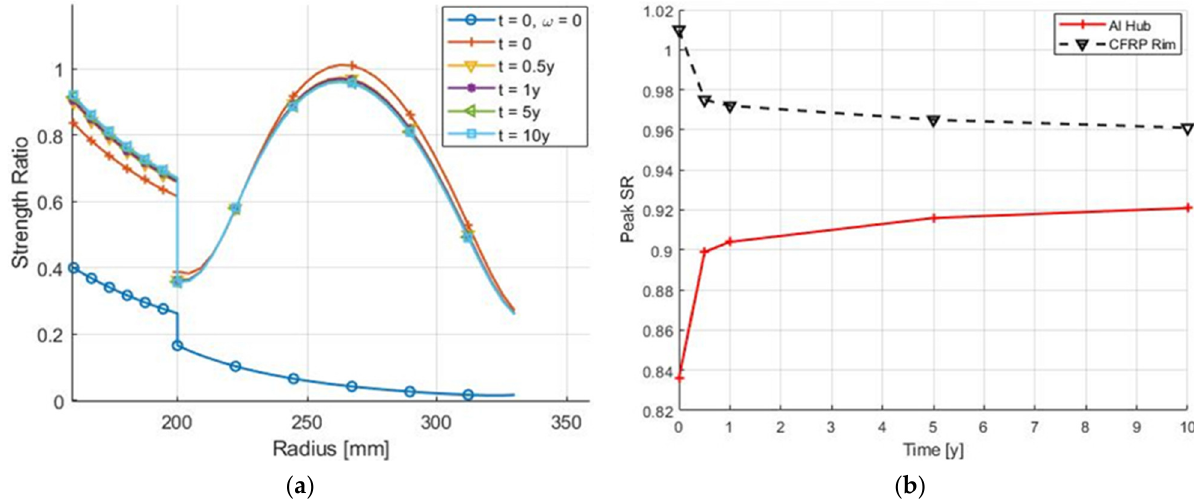
Figure 5. Strength ratio ( SR ) data for the flywheel rotor ( a ), and peak SR in the aluminum hub and CFRP rim at various times throughout the simulated lifetime ( b ).